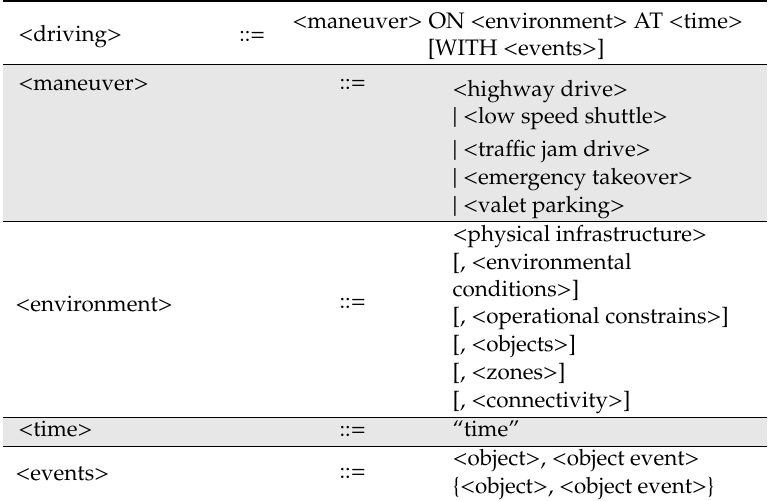
Table 1. The first stage of driving